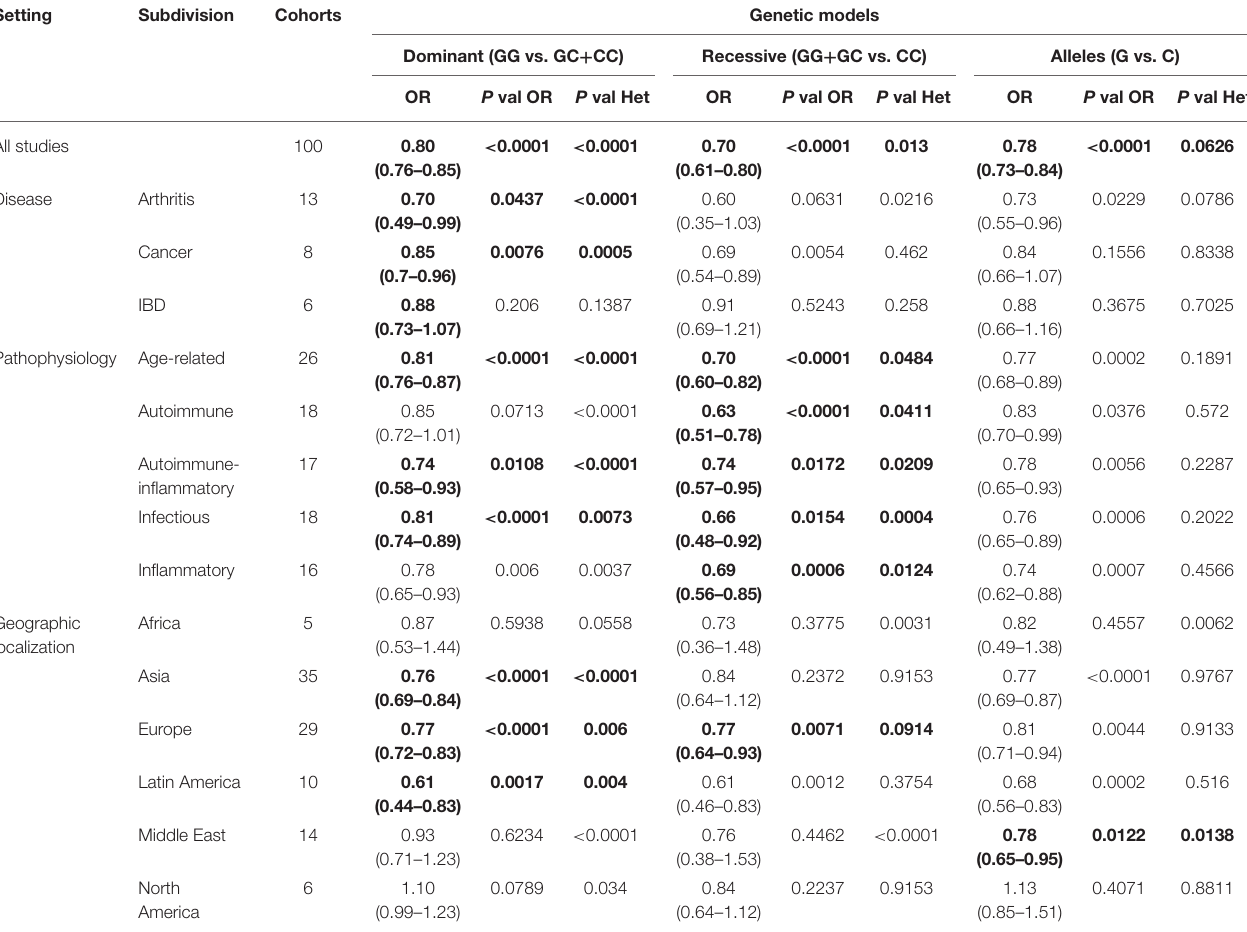
TABLE 2 | Summary of the overall and all subdivisions meta-analysis results on the dominant, recessive, and allelic models.